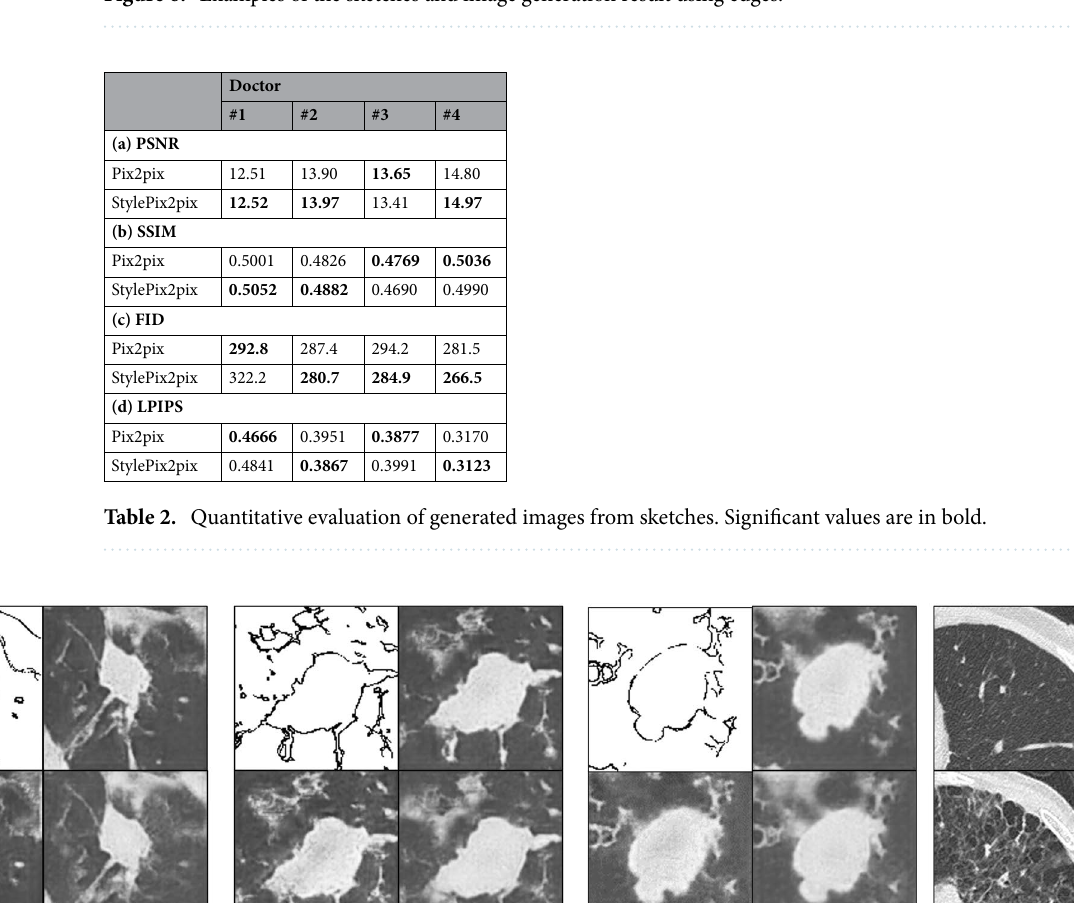
Figure 6. Examples of the sketches and image generation result using edges.